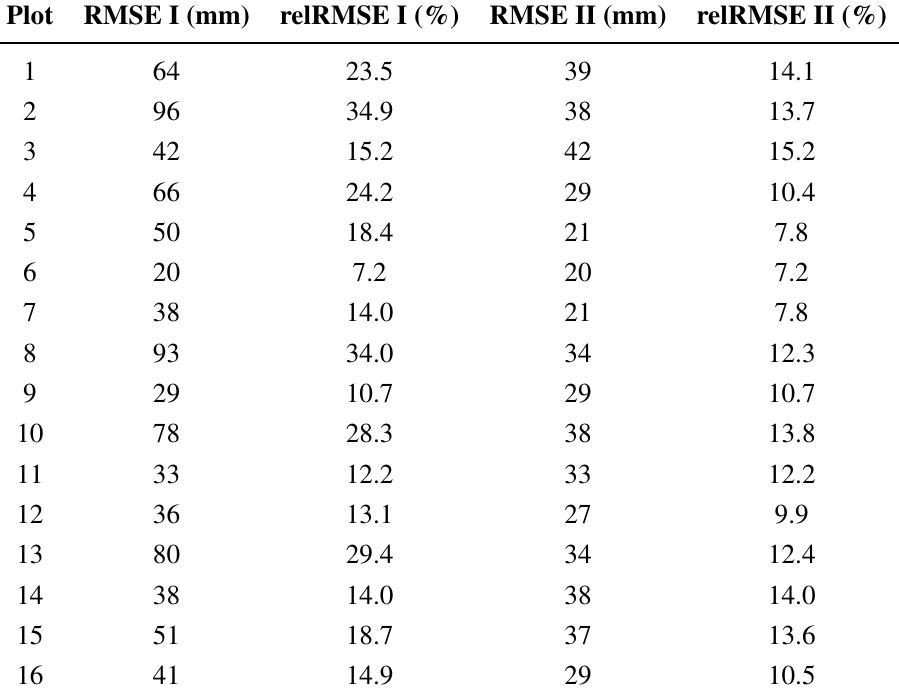
Table 5. Stem diameter estimates for each plot, (I) complete dataset, and (II) dataset with the outliers removed.